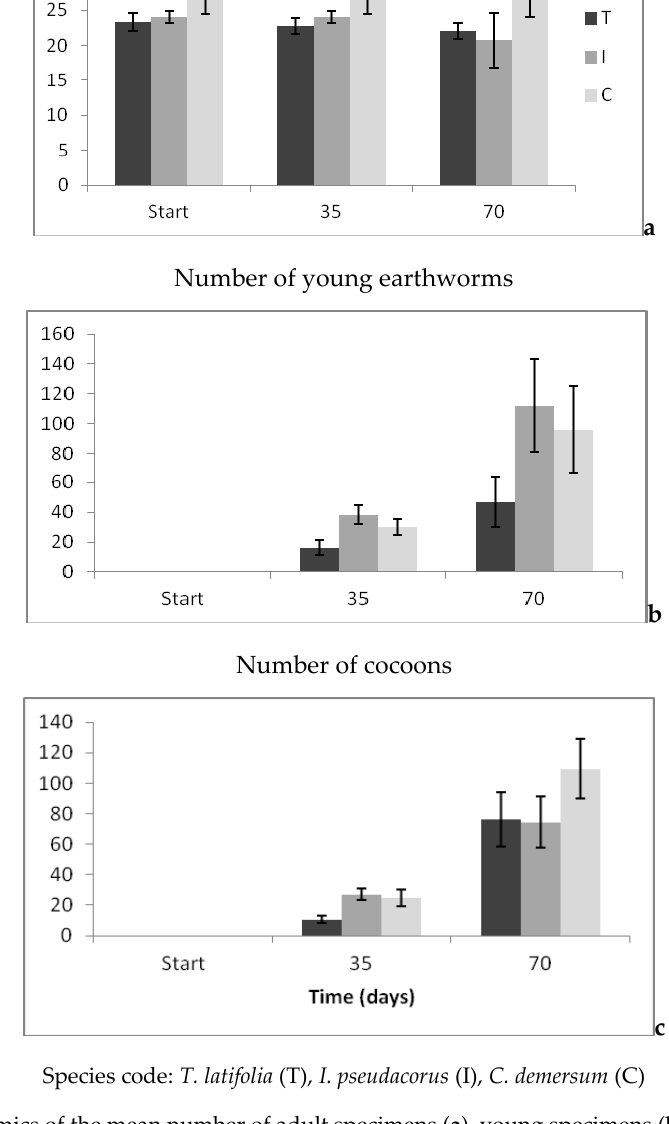
Figure 3. Dynamics of the mean number of adult specimens ( a ), young specimens ( b ) and cocoons ( c ) in the process of vermicomposting of littoral plant biomass.